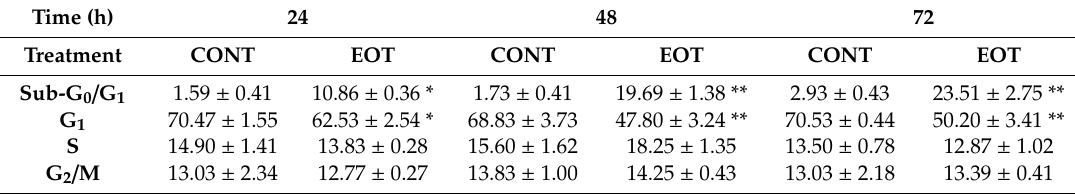
Table 3. The cell cycle distribution in MCF-7 cells after thyme essential oil (EOT) treatment.